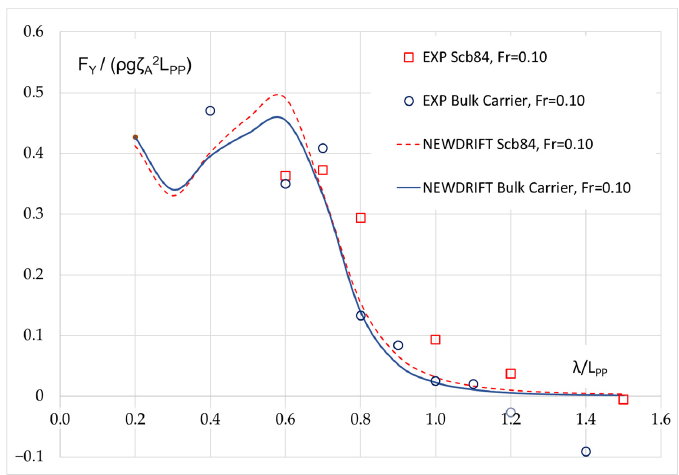
Figure 7. Mean sway force in regular beam waves, Fr = 0.10.